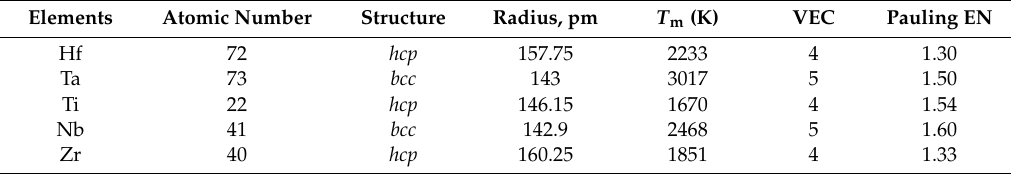
Table 1. Properties of the elements under consideration [8] (see the text for details). hcp, hexagonal closest packed; bcc, body-centered cubic; fcc, face-centered cubic; VEC, valence electron concentration; EN,